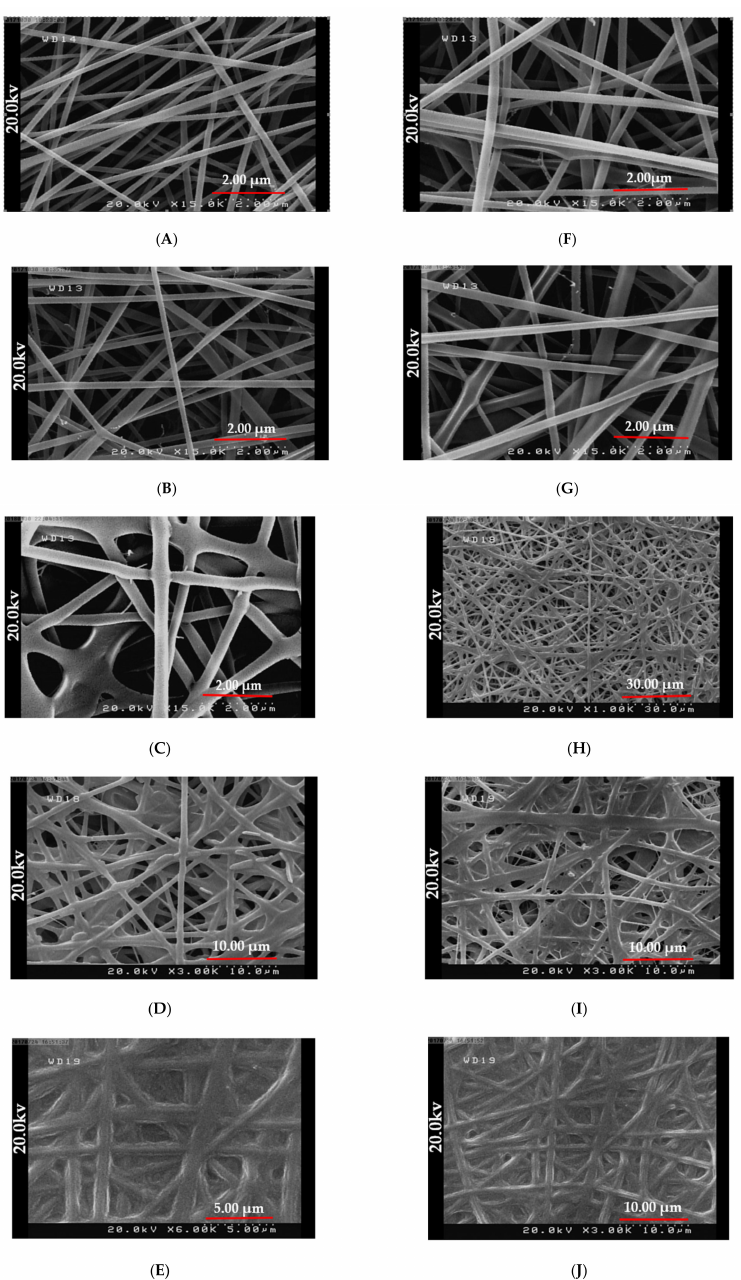
Figure 1. The FESEM images ( A ) PDDA/honey nanofiber composite 50/50 (20 KV), ( B ) crosslinked PDDA/honey nanofiber composite (50/50) for 2 h, ( C ) crosslinked PDDA/honey nanofiber composite (50/50) for 3 h, ( D ) crosslinked PDDA/honey nanofiber composite (50/50) for 4 h, ( E ) crosslinked PDDA/honey nanofiber composite (50/50) for 5 h, ( F ) PDDA/honey nanofiber composite 40/60 (17 KV), ( G ) crosslinked PDDA/honey nanofiber composite (40/60) for 2 h, ( H ) crosslinked PDDA/honey nanofiber composite (40/60) for 3 h, ( I ) crosslinked PDDA/honey nanofiber composite (40/60) for 4 h, and ( J ) crosslinked PDDA/honey nanofiber composite (40/60) for 5